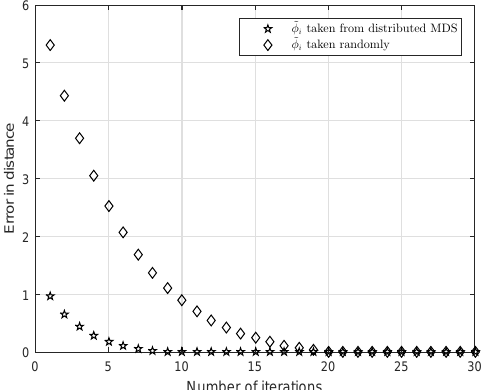
Figure 2. Estimate of blind machines (BM) vs. number of iterations using Equation (10).